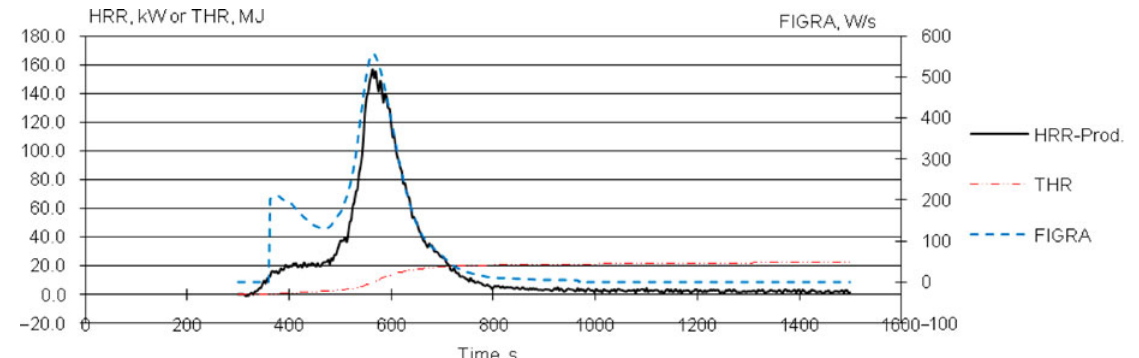
Fig. 8. Image of non-impregnated 6-mm-thick OSB during the test (a) and after terminating the test (b)